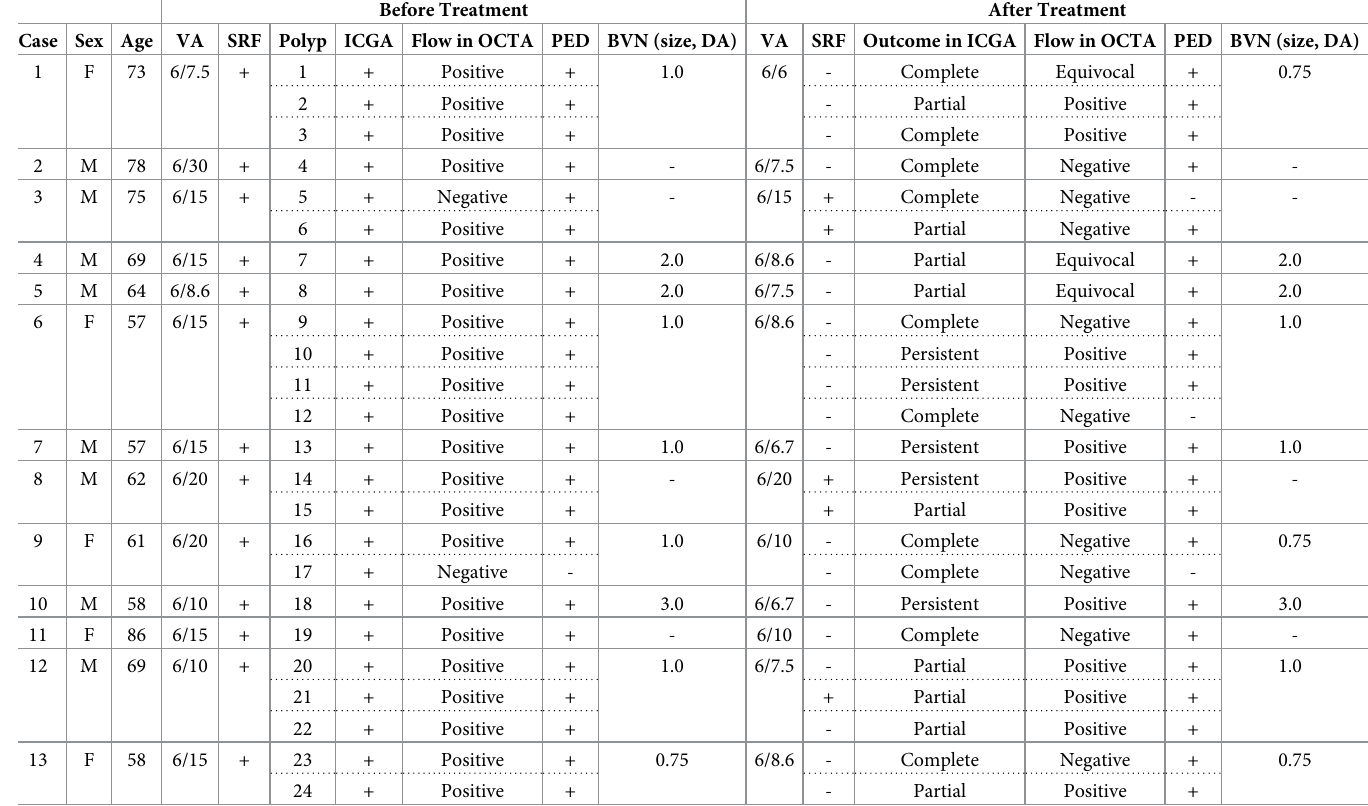
Table 1. Demographic data and clinical profile of the 24 polyps in 13 patients before and after